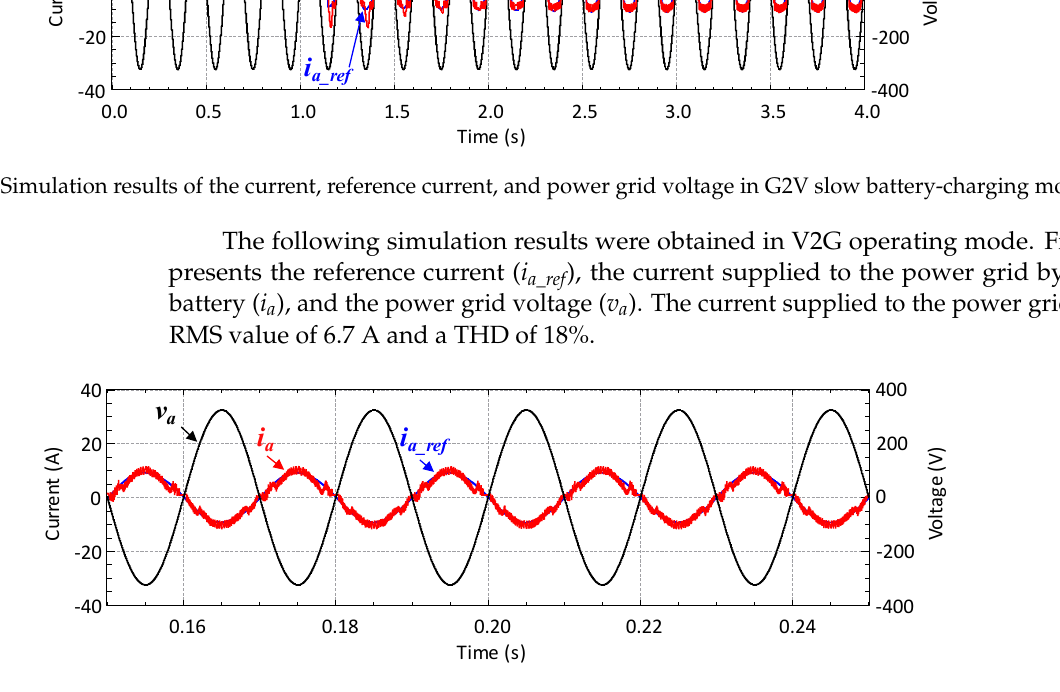
Figure 25. Simulation results of the power grid voltage, current, and reference current in V2G mode.